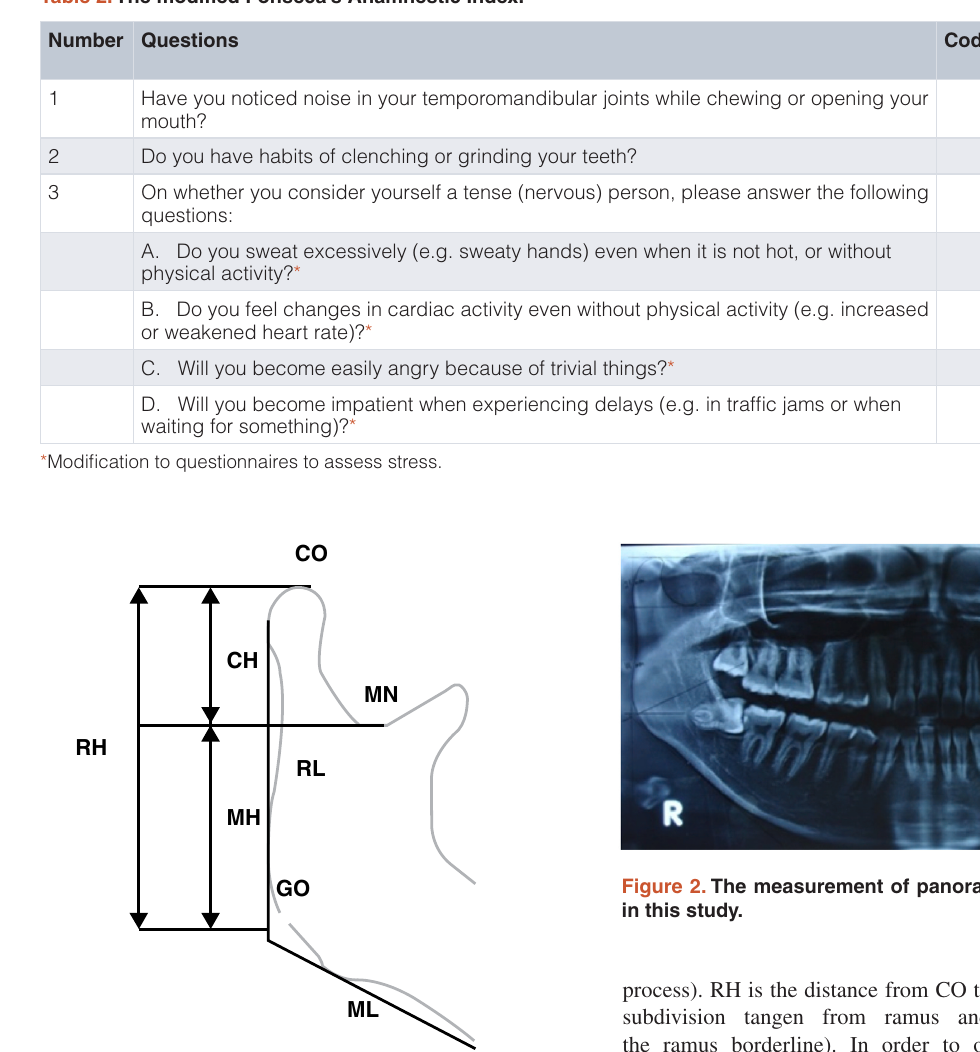
Table 2. The modified Fonseca’s Anamnestic Index.